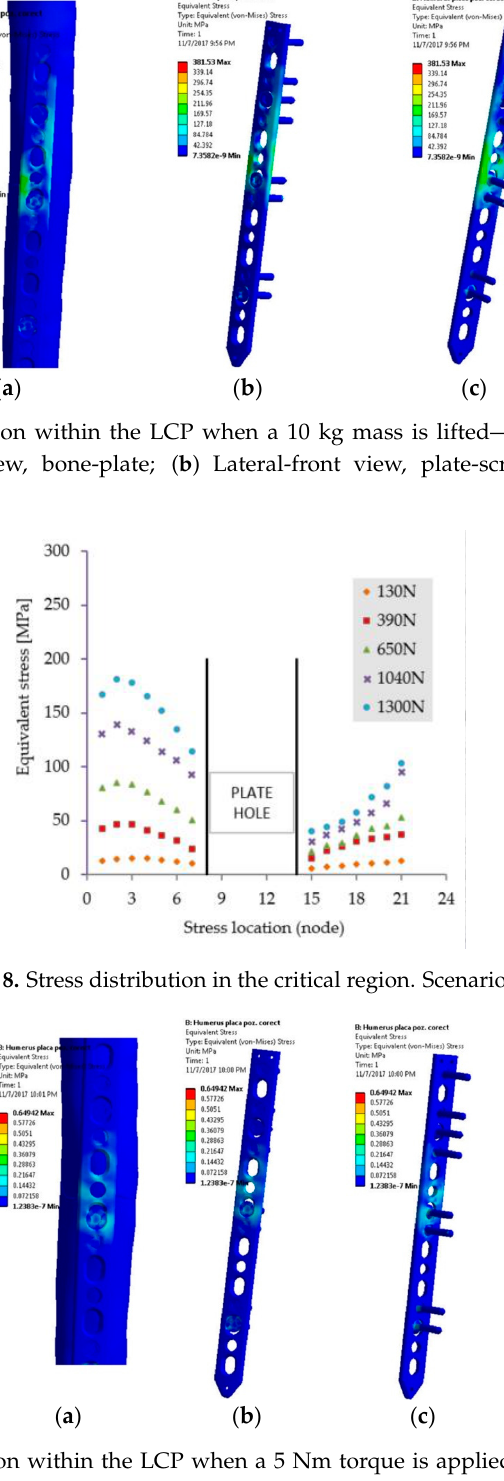
( a ) Lateral view, bone-plate; ( b ) Lateral-front view, plate-screws; ( c ) Lateral-back view, plate-screws.